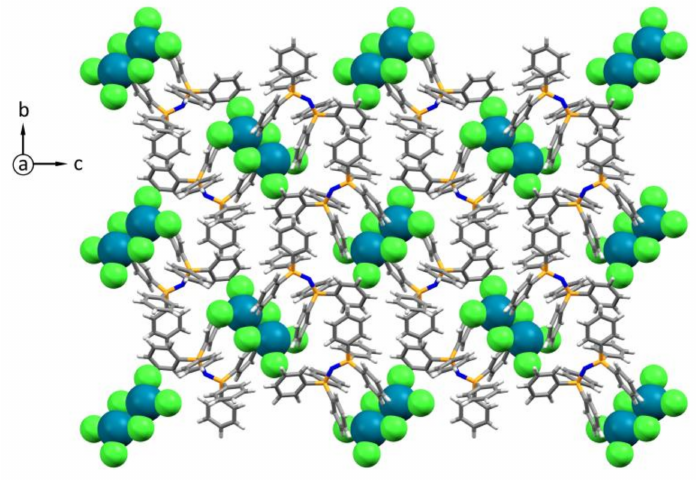
Figure 4. Crystal packing of 2 along the crystallographic axis a , highlighting the isolation of the chloro-anions (in ball and stick representation) by means of bis(triphenylphosphine)iminium cations (in capped sticks